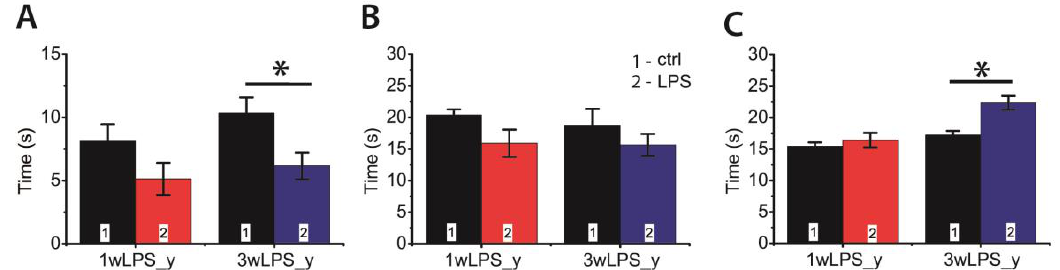
Figure 8. The behavior of P23-25 rats in the open field-test, which were treated with LPS during the first (1wLPS_y) or third (3wLPS_y) weeks. ( A ) Total time of hole exploration (e ff ect of treatment: F 1,50 = 11.2; p = 0.002); ( B ) Time of locomotion (e ff ect of treatment: F 1,54 = 4.01; p = 0.05); ( C ) Duration of movement on the spot (interaction time × treatment: F 1,51 = 5.3; p = 0.03; time: F 1,51 = 17.9; p < 0.001; treatment: F 1,51 = 11.1; p = 0.002). * p < 0.05 (Tukey post hoc test).